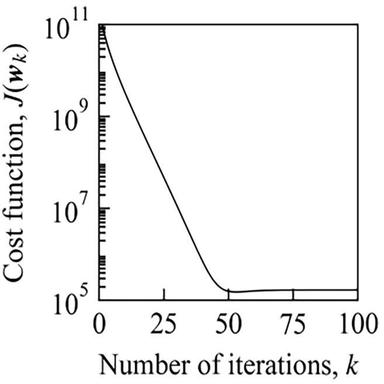
Evolution of the cost function, J(wk), at each iteration step.